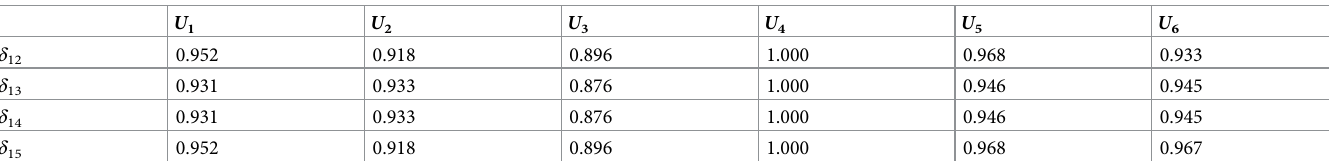
Table 14. The relative weight of O 1 to